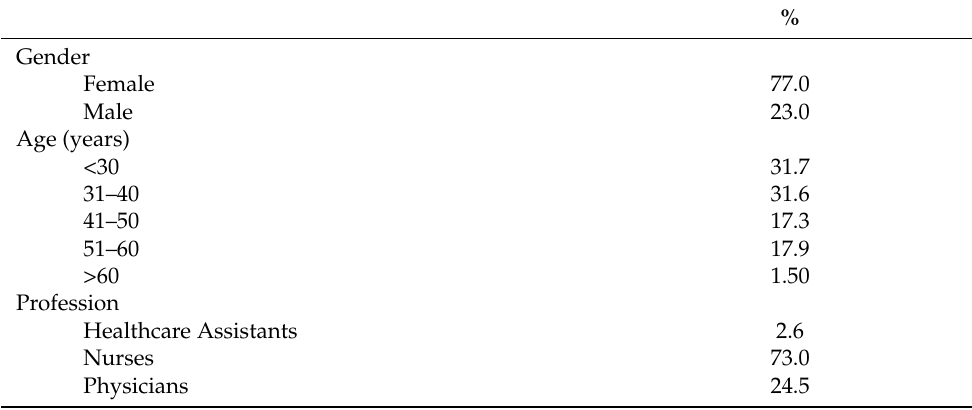
Table 2. Descriptive statistics of the sample’s sociodemographic